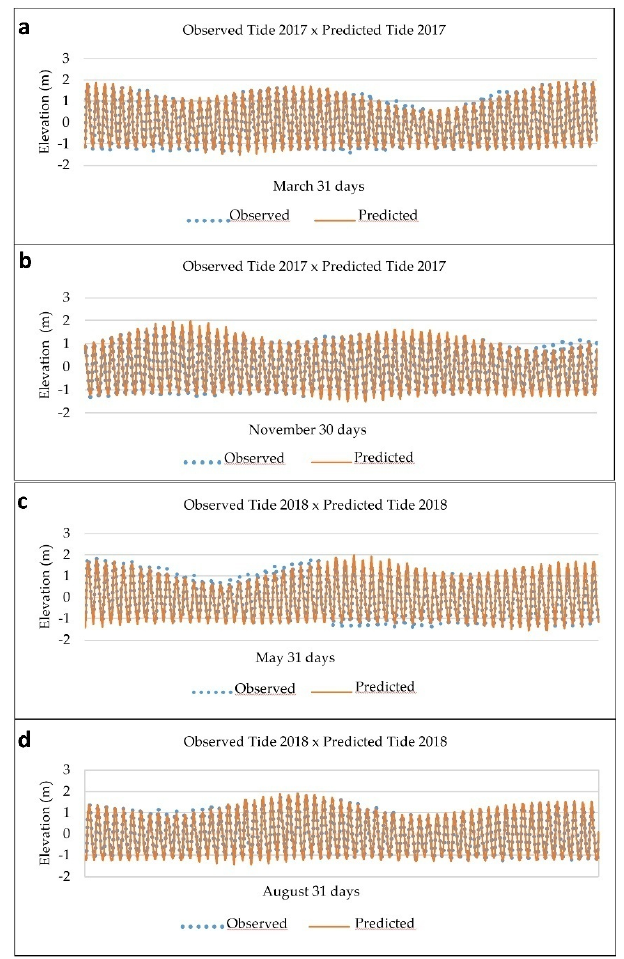
Figure 6. Comparison between predicted and real tide: ( a ) March 2017; ( b ) November 2017; ( c ) May 2018 and ( d ) August 2018.